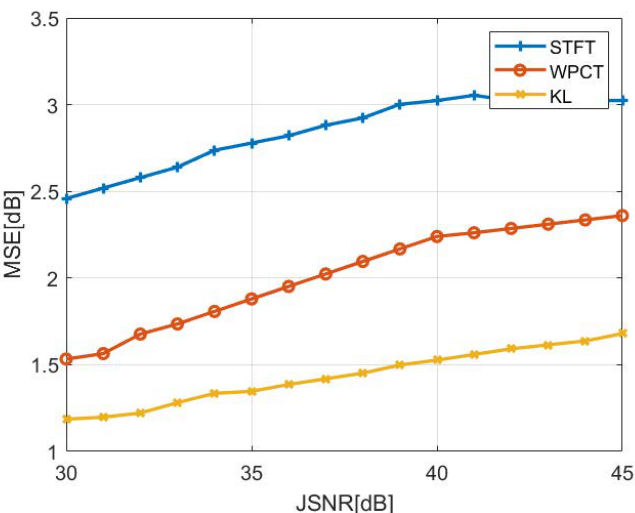
Figure 9. MSE of different interference mitigation algorithms under pulse signal